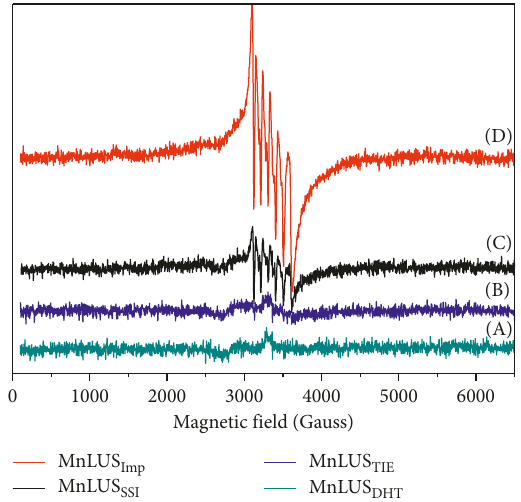
Figure 5: EPR spectra at 120K of MnLUS samples (7